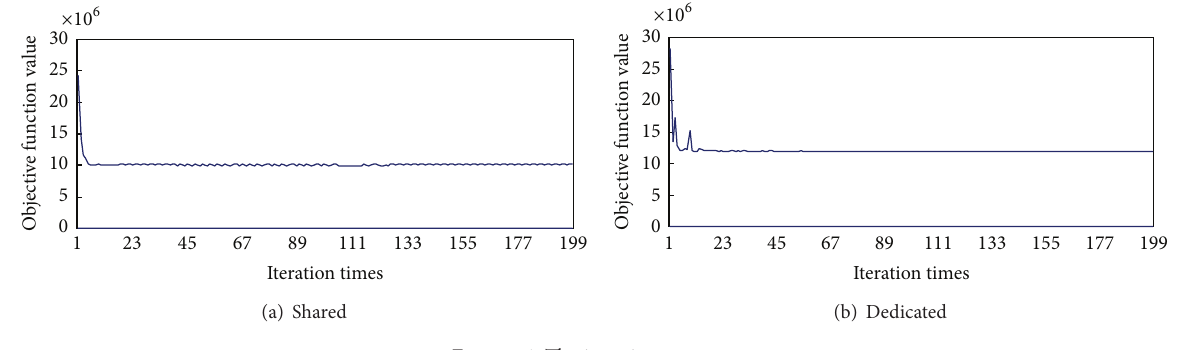
Figure 4: The iteration process.